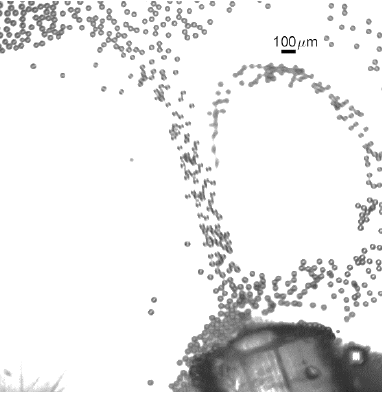
Figure 13. Bubbles acquired at the outlet of the hybrid device.